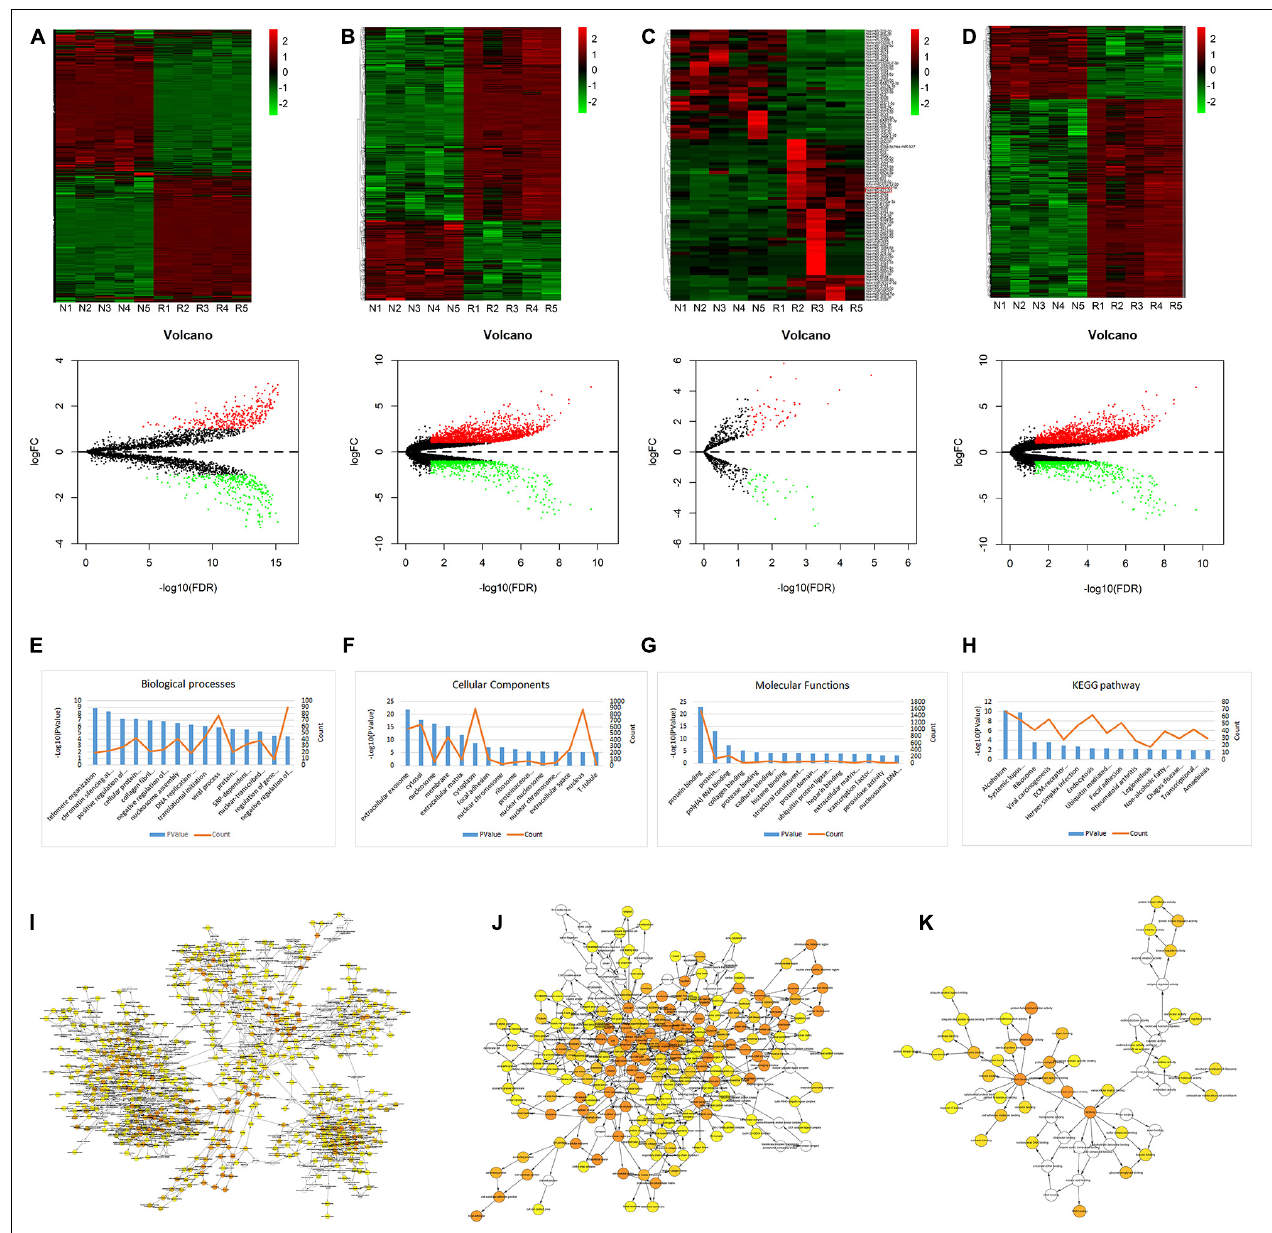
FIGURE 1 | Heat map, volcano plots, GO annotation, and KEGG analysis of DEGs. (A–D) Heat map and volcano plots of circRNAs (A) , lncRNAs (B) , miRNAs (C) , and mRNAs (D) . The upper heat maps are based on expression values of significantly differentially expressed ncRNAs and mRNAs (absolute fold change ≥ 2.0 and p < 0.05) detected by microarray probes. “Red” and “Green” indicate expression above and below, respectively, relative expression. R = IDD group; N = control group. The bottom volcano plots reflect the number, significance, and reliability of differentially expressed ncRNAs and mRNAs. Red dots are up-regulated genes, green dots are down-regulated genes, and black dots are genes that were the same between the two groups. (E–H) GO annotation and KEGG analysis of differentially expressed mRNAs, with the top 15 enrichment scores covering domains of biological processes (E) , cellular components (F) , molecular functions (G) , and significant pathways (H) . Enrichment score values were calculated as –log 10 ( p -values). (I–K) The BP (I) , CC (J) , and MF (K) were visualized in